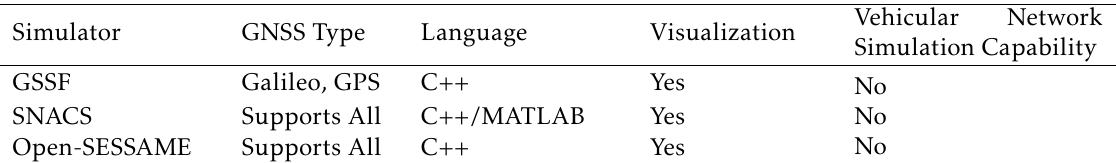
Table 1. Comparison of software based GPS